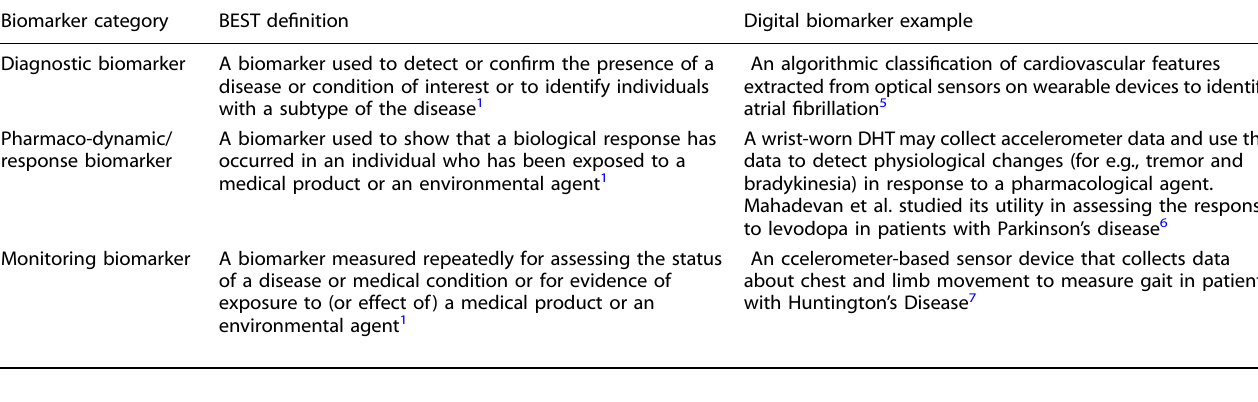
Table 1. Examples of digital biomarkers from published literature.